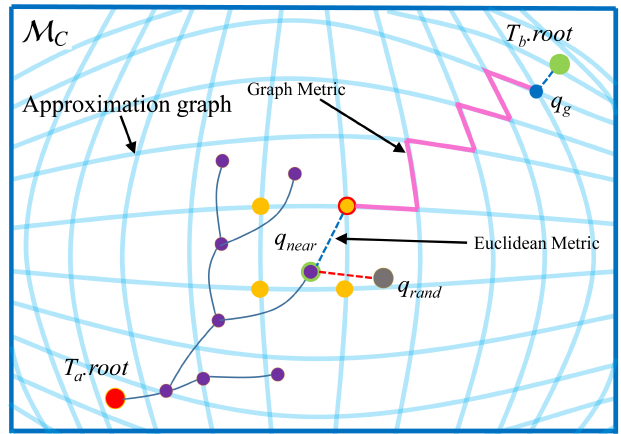
Figure 3. The diagram of selecting the nearest candidate neighbors. The grey point q rand is a random sampling configuration in the C-space (not on the constraint manifold). The purple point with green contour q near is the nearest neighbor of q rand on T a . The yellow point is one candidate neighbor of q near on the manifold approximate graph. Through the Euclidean metric (blue dotted line) between the candidate nearest neighbors and q near , and the graph metric (pink line) between the candidate nearest neighbors and the q g , the estimated cost of each candidate nodes can be calculated. The candidate neighbor with the lowest cost (yellow point with red contour) is chosen as the extension target of q near